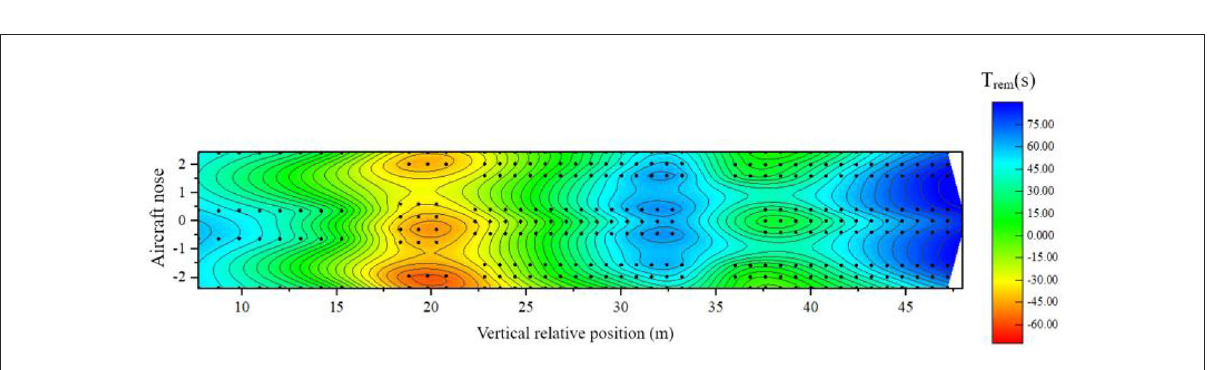
FIGURE22 Distribution of remaining evacuation time after adding